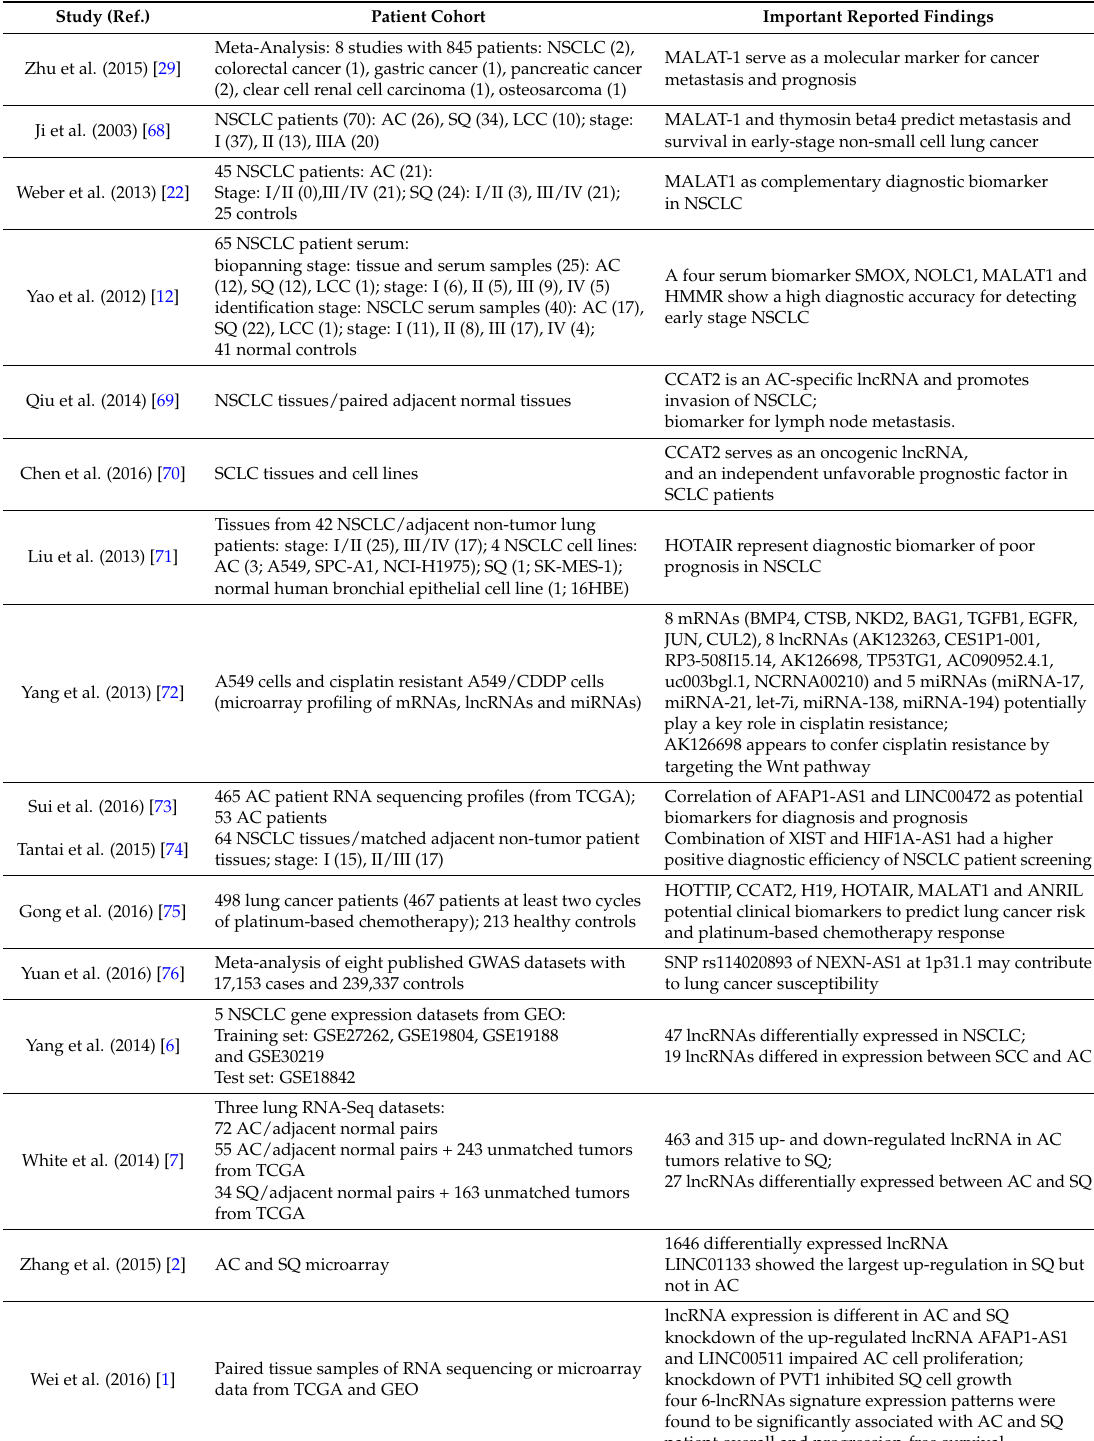
Table 2. Table summarizing the different lung cancer lncRNA